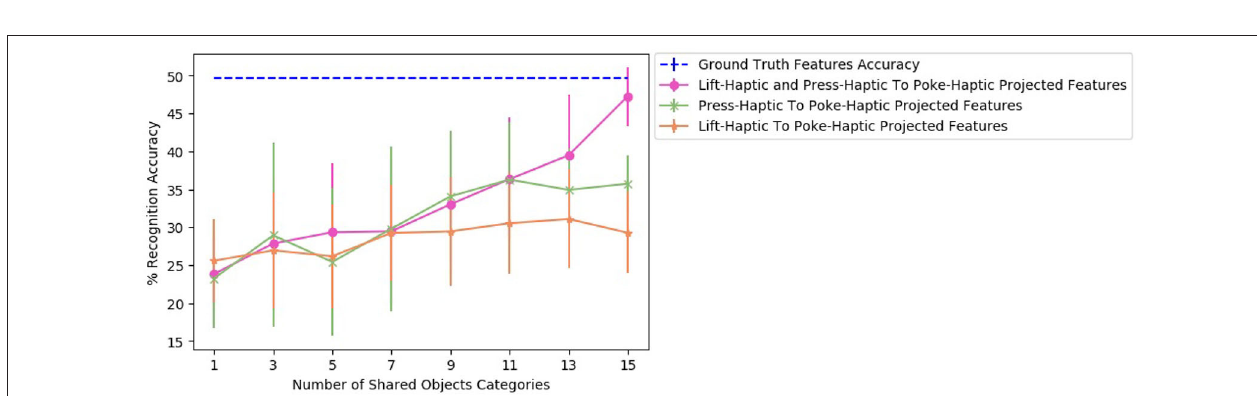
FIGURE 15 | Two sources β -VAE cross-behavior projections where the recognition accuracy improves as compared with corresponding β -VED projections.